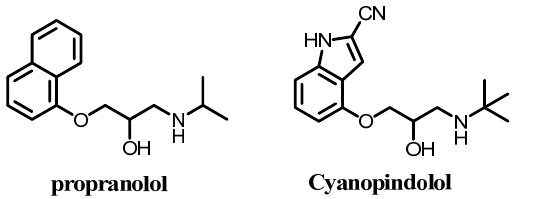
Figure 2. Chemical structures of propranolol and cyanopindolol.